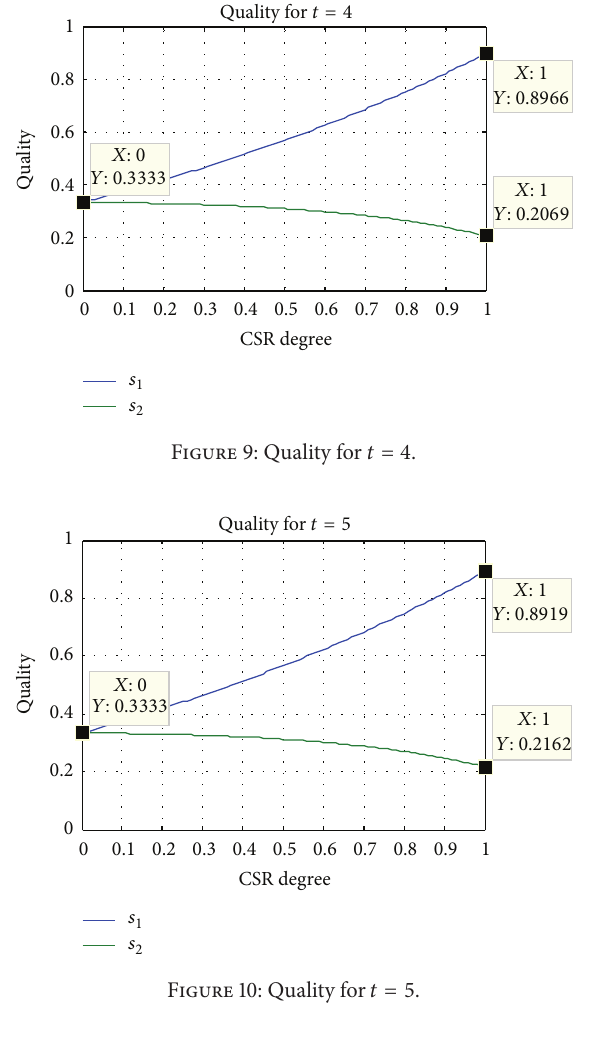
Figure 9: Quality for 𝑡 = 4 .